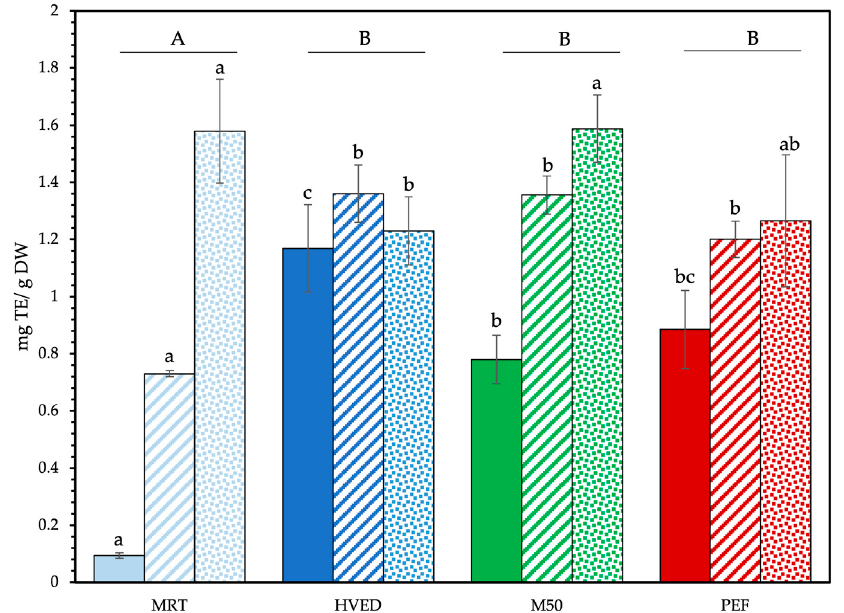
Figure 5. Antioxidant activity of 1:20 extracts. Solid fill: fresh GC; dashed fill: dry GC; dotted fill: powdered GC. Data are shown as mean ± SD (n = 4). Upper case letters signify differences between treatments (values averaged across state). Lower case letters denote significant differences between treatments by state. Type III ANOVA with Tukey post-hoc test.